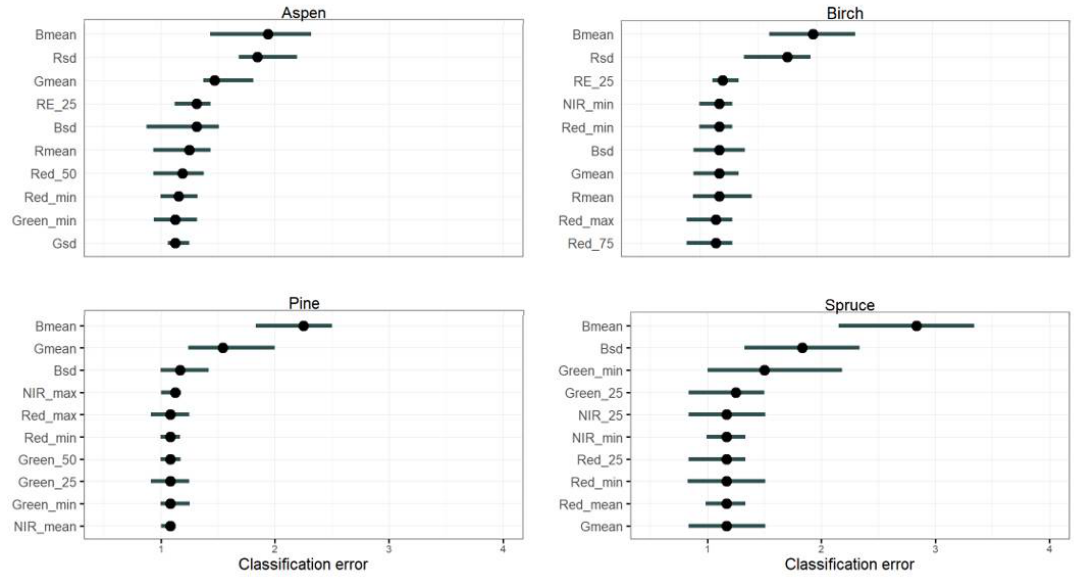
Figure 5. Permutation feature importance for classification of the 4 tree species applying the SVM model for the Sequoia dataset (10 most important features).